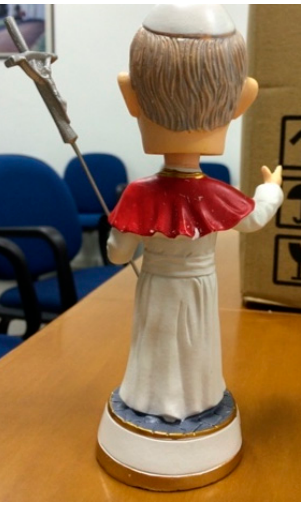
Figure 1. Example of a statuette investigated in this study.